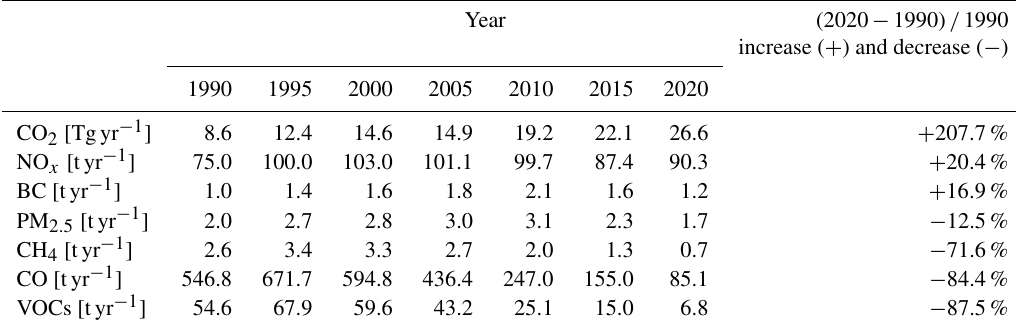
Year (2020 − 1990) / 1990 increase ( + ) and decrease ( − )